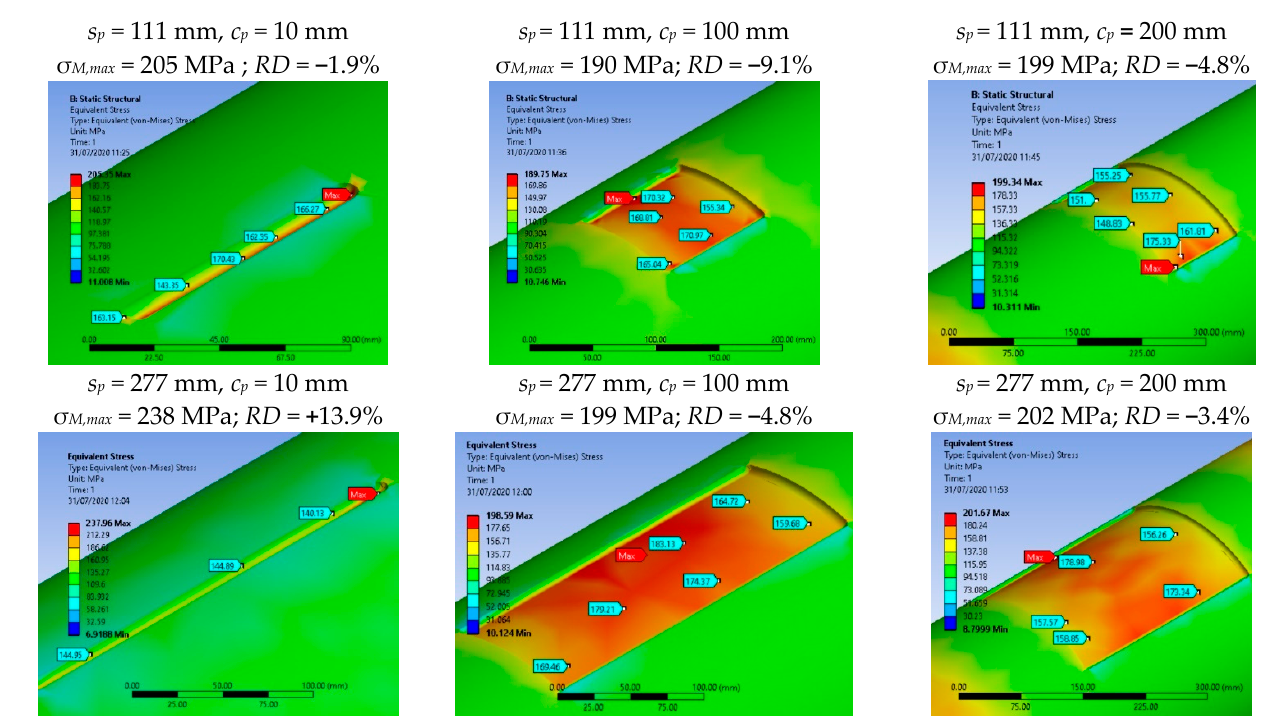
Scheme 1. Sensitivity analysis on the defect width. FEA results.